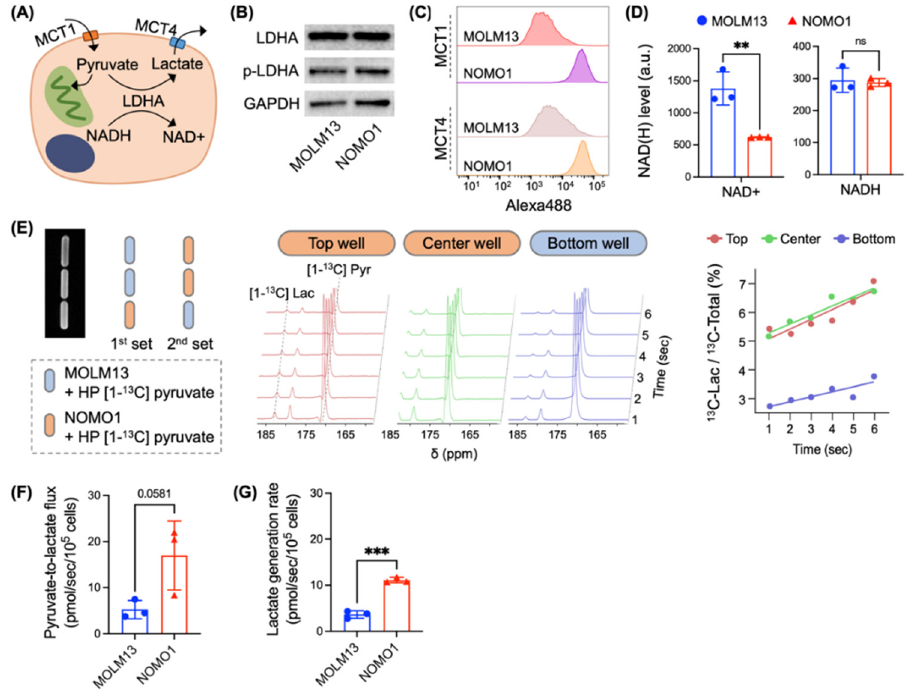
Figure 3. Micro-slab MR coil with hyperpolarized [1- 13 C] pyruvate enables simultaneous assessment of metabolic flux in different living cells. ( A ) Schematic of pyruvate-to-lactate metabolism. Pyruvate is transported into a cell through monocarboxylate transporter 1 (MCT1) and lactate is transported out through MCT4. ( B ) The expression level of LDHA and its phosphorylated form (p-LDHA) in MOLM13 and NOMO1 cells. Original Western blot images are provided in Supplementary Figure S3. ( C ) The surface expression level of MCT1 and MCT4 in MOLM13 and NOMO1 cells. ( D ) Levels of NAD + and NADH in MOLM13 and NOMO1. ( E ) Example dataset of hyperpolarized experiment with MOLM13 and NOMO1 cells in the 3-well micro-slab coil. T 2 -weighted 1 H-MR image showing filled sample wells and schematic of sample loading procedure (Left). Dynamic 13 C-MR spectra from the 2nd set of samples, with NOMO1 loaded in top and center wells and MOLM13 loaded in bottom well (Middle). Graph of [1- 13 C] lactate signal divided by total 13 C-MR signal against time (Right). The slope of a linear fit to these points is normalized by HP [1- 13 C] pyruvate concentration and number of cells to give the pyruvate-to-lactate flux rate. ( F ) Pyruvate-to-lactate flux of MOLM13 and NOMO1 cells measured in the experiment ( E ). ( G ) Lactate generation rate of MOLM13 and NOMO1 cells based on the difference in lactate level in the media and cell number after 24 h of culture. All graphs show mean ± SD ( n = 3 technical replicates) and are representative of two independent experiments. Statistical analyses were conducted with unpaired two-tailed t test: ns (not significant) p > 0.05, ** p < 0.01, *** p <